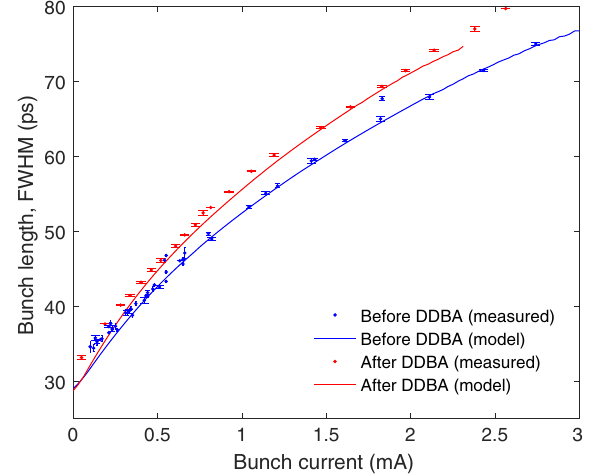
FIG. 9. Full-width at half-maximum (FWHM) bunch length as a function of current. The error bars on the measured data show the standard error over 801 samples.